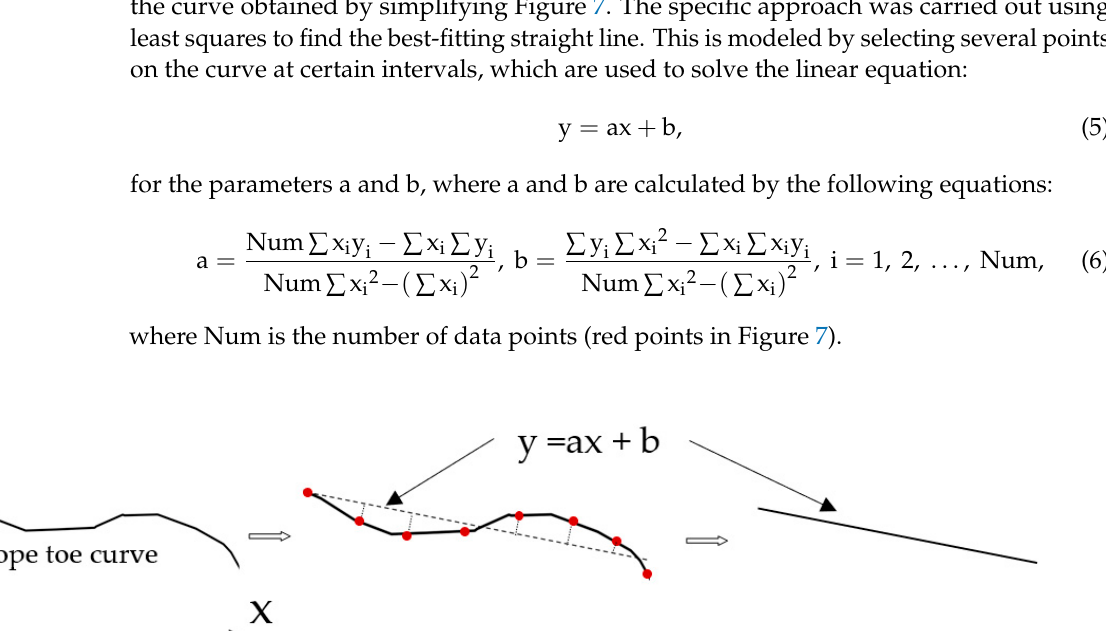
Figure 6. Mine surface simplification: in the XY flat, closest to the camera is the slope line where the red curve in the diagram is located. The closer the distance, the smaller the camera’s sensing range. If this line can be fully covered, other heights of the slope must be covered, so we have chosen this line to represent the situation of the mine surface in the XY plane.